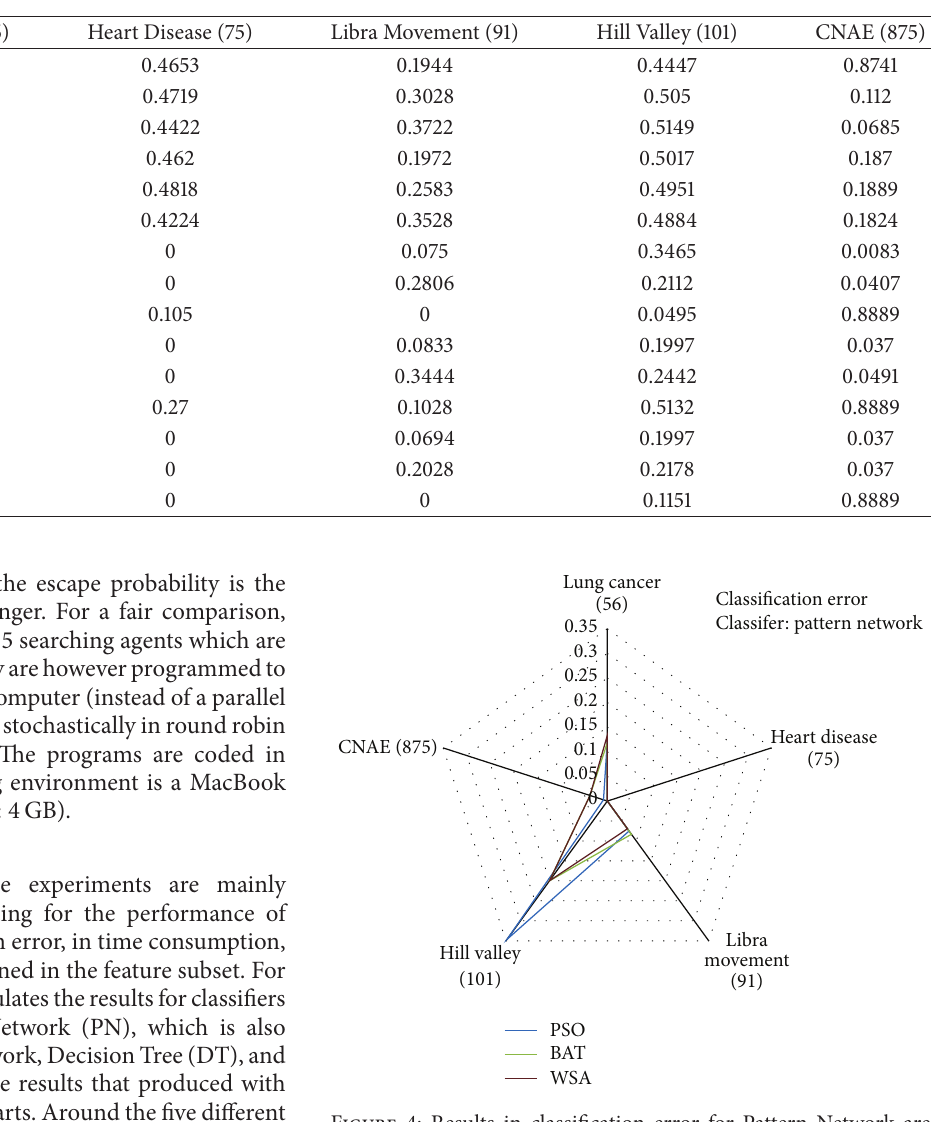
Table 5: Comparative results in classification error for all the classification algorithms with Cfs feature selection and swarm search feature selection and without any feature selection.